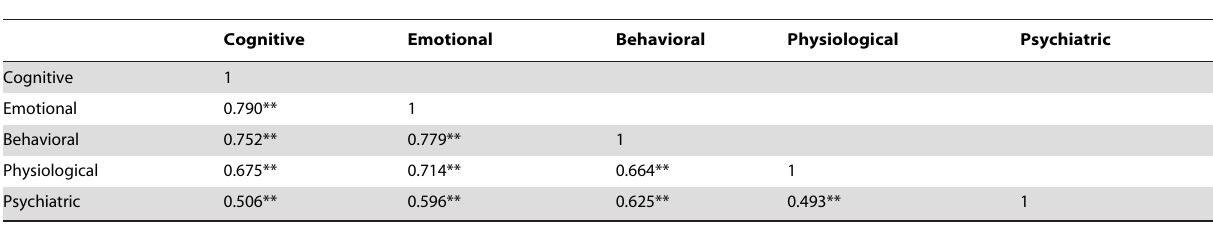
Table 1. Correlations between Different Sub-scales of